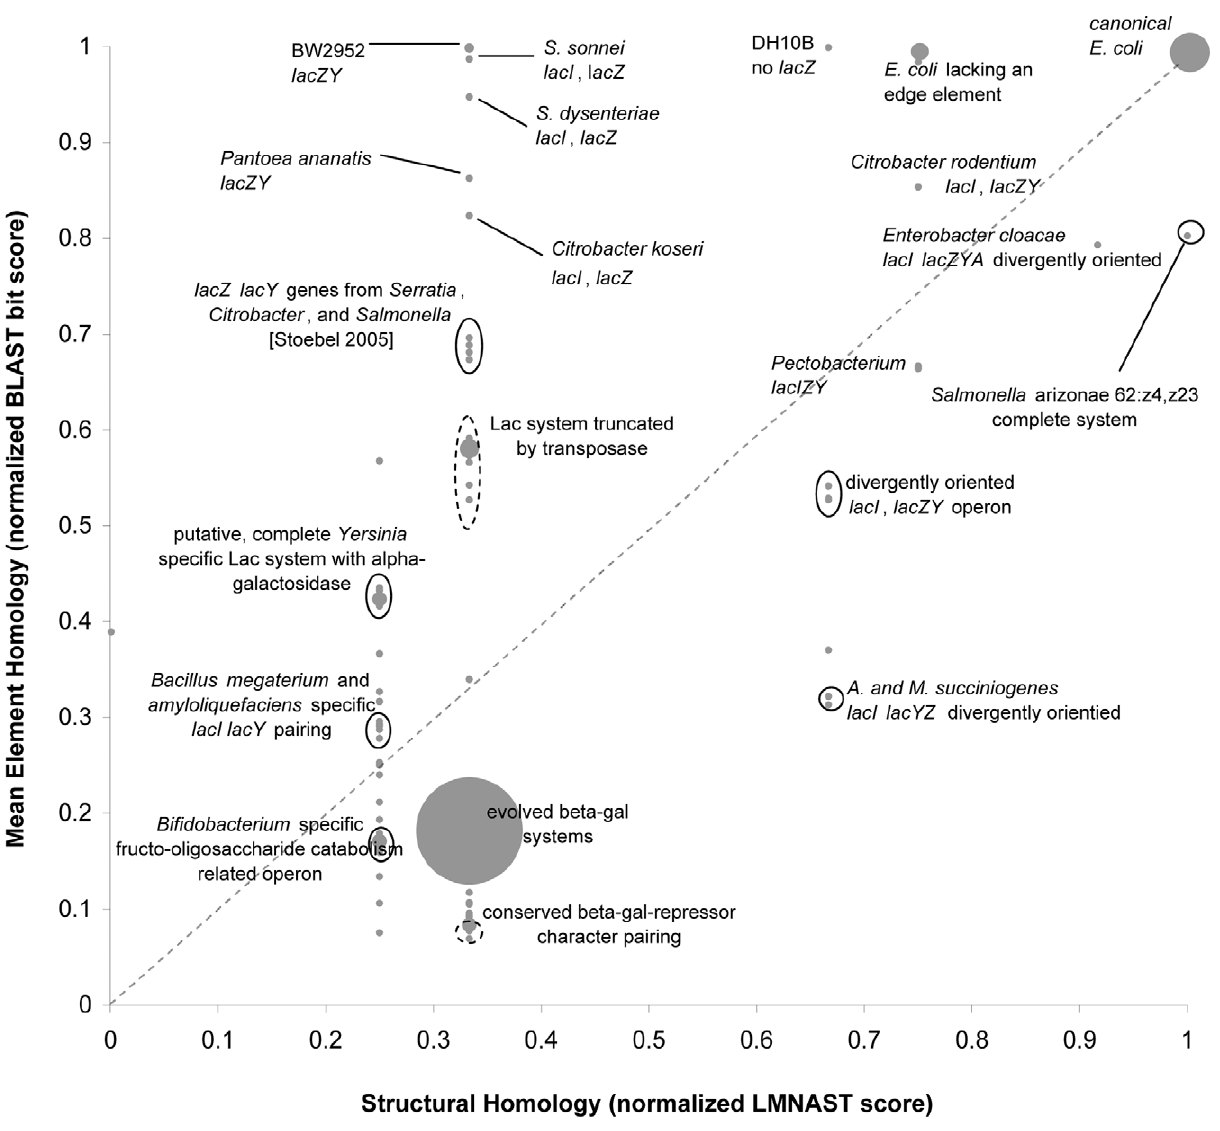
Figure 5. 2D Similarity Plot of Lac operon LMNAST stringent search hits overlaid with attributed annotation. Each gray dot represents the homology coordinate of a hit. The size of the dot scales directly with the number of hits at the same coordinate. The dashed line is a 1:1 line along which hits have the same degree of homology by both BLAST and LMNAST measures. Seemingly vertical displacements may imply horizontal gene transfer, while horizontal displacements may imply gene loss or arrangement within the same or proximal species. Ovals indicate a clustering of similarly annotated hits. Dashed ovals denote cases where only the majority of hits therein share the labeled Genbank annotation. Here, the dominant features are systems mirroring the original structure and the evolved beta-galactosidase system. Very little HGT is apparent while gene loss and rearrangement are ostensibly more common.